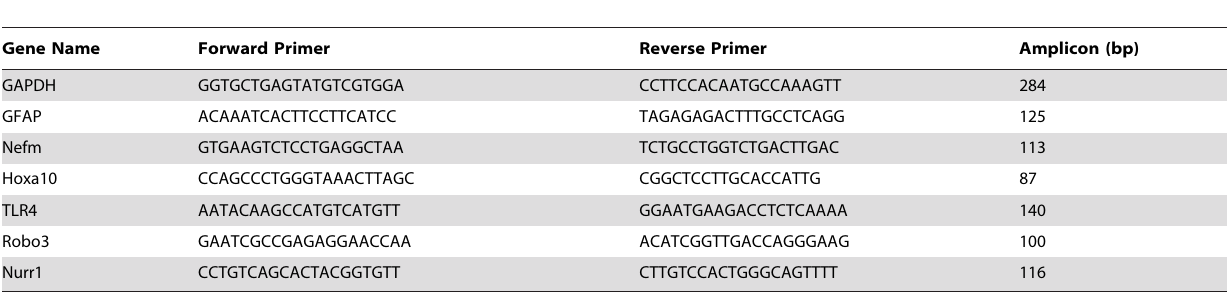
Table 1. qPCR primer sequences and expected amplicon